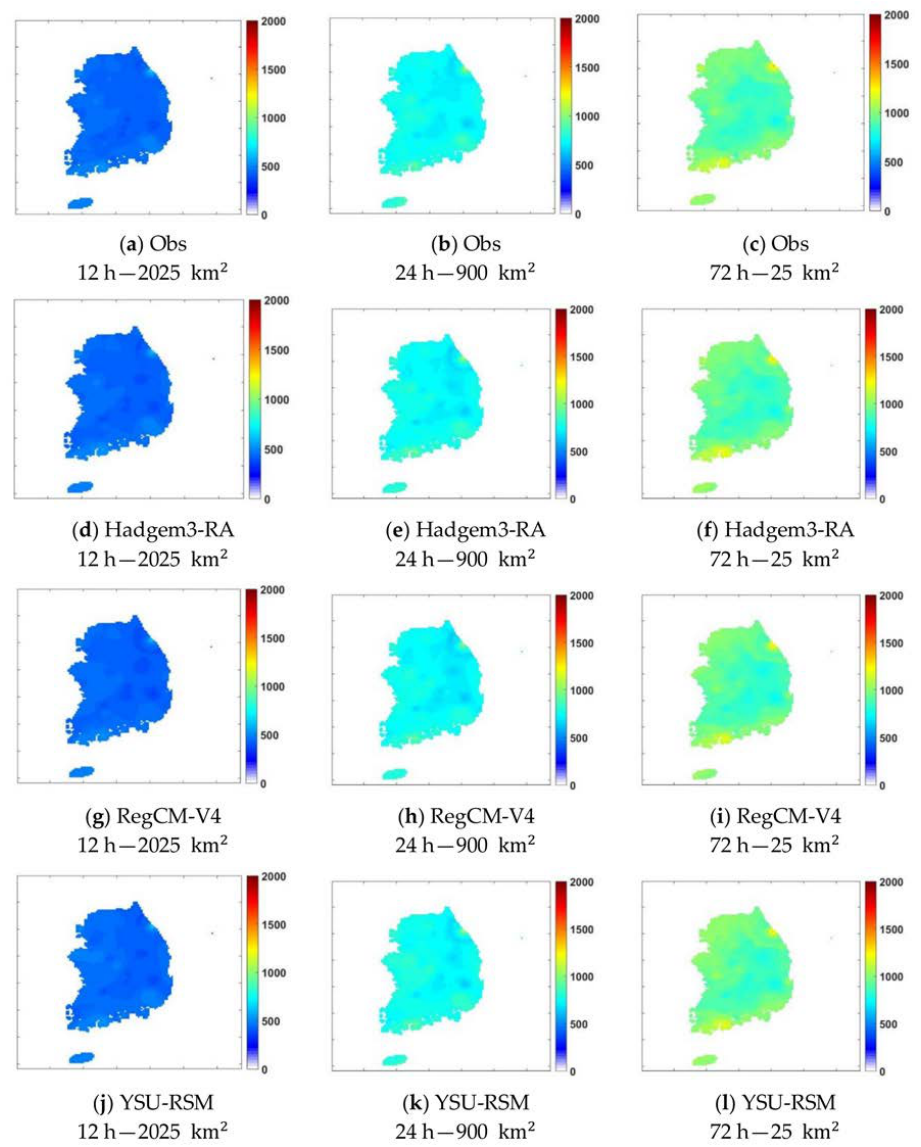
Figure 9. Comparison between PMPs estimated from observed data and PMPs estimated from present-climate data simulated by various